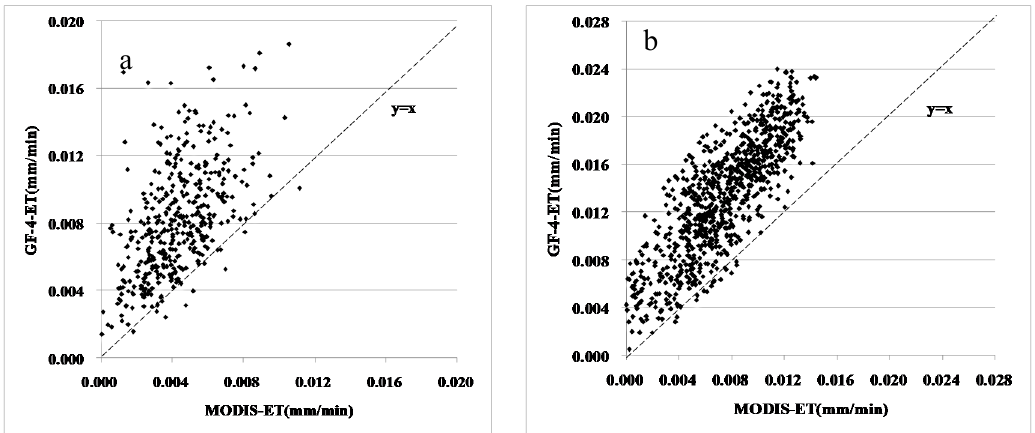
Figure 5. Cross-validation of simulated ET of GF-4 and MODIS; ( a ) ET at 11:35 of MODIS and 11:36 of GF-4 in areas CB,CG and CF; ( b )ET at 13:45 of MODIS and 13:50 of GF-4 in areas KB,KE and KD).